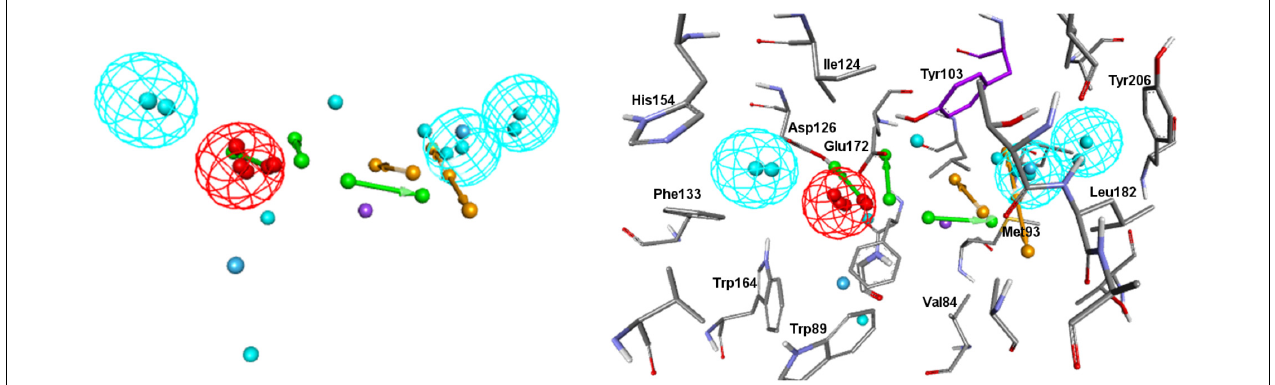
FIGURE 7 | Visualization of the five pharmacophore models (Langer, Gund, Zampieri, Banister and 5HK1-Ph.A) overlapped in the binding site. Location spheres are only shown for 5HK1–Ph.A . TABLE 2 | Area under the ROC curve, sensitivity, specificity, enrichment factors and hit rates at 1%, 5% and 10% of screened compounds using six different pharmacophore models, with both rigid and flexible fit. ROC Sensitivity AUC (TPR)